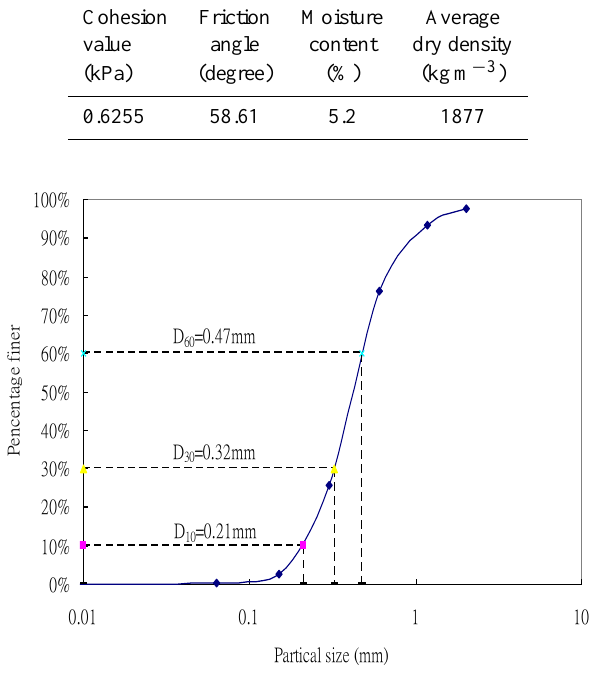
Figure 3 Particle size distribution Figure 4 Shear-Normal stress relation for sand Figure 3. Particle size distribution.